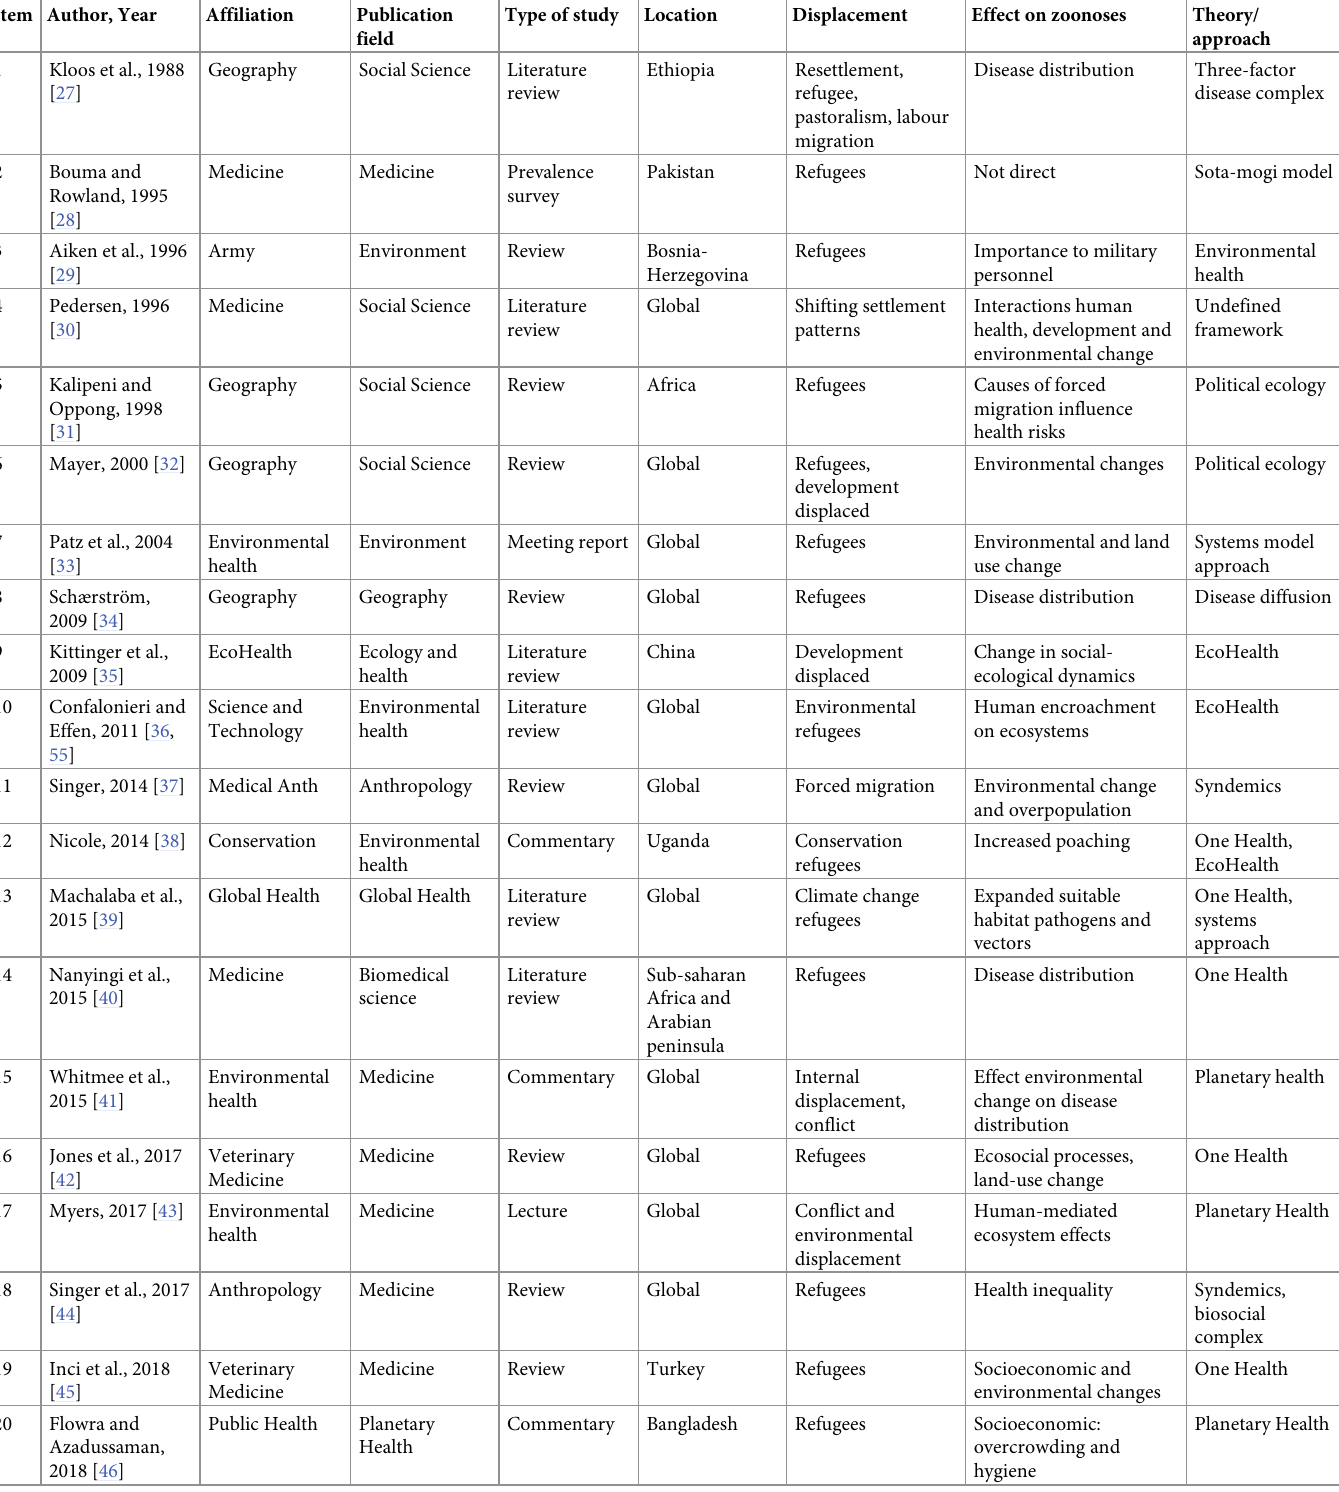
Table 1. Publication characteristics and